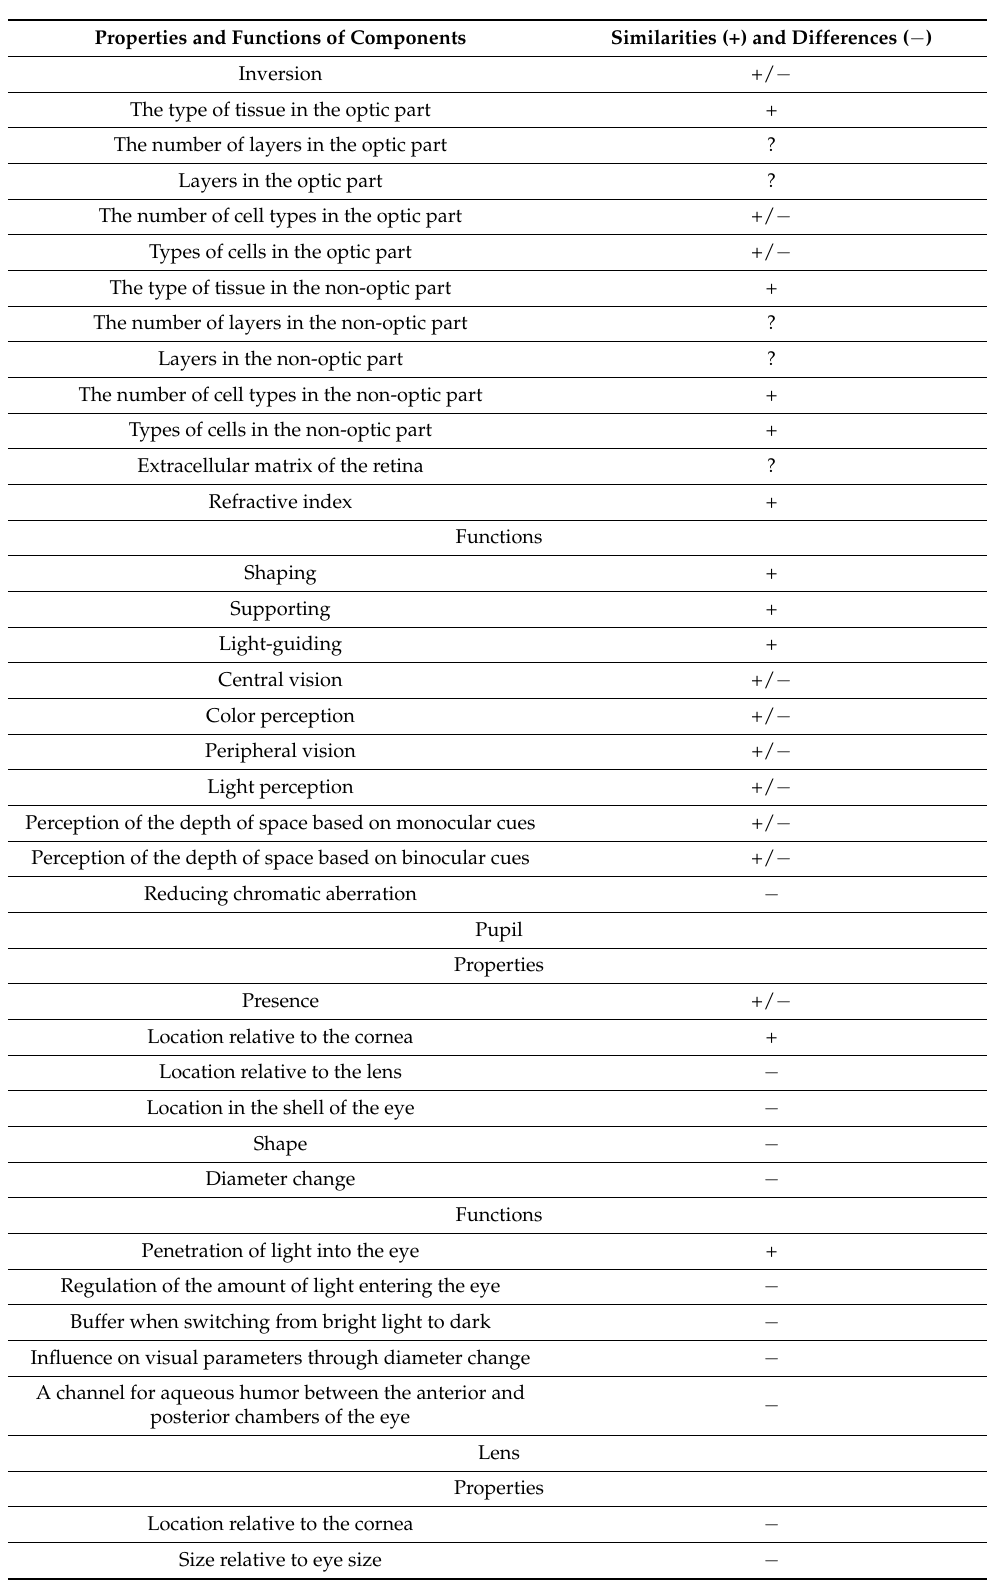
Table 1. Cont. Properties and Functions of